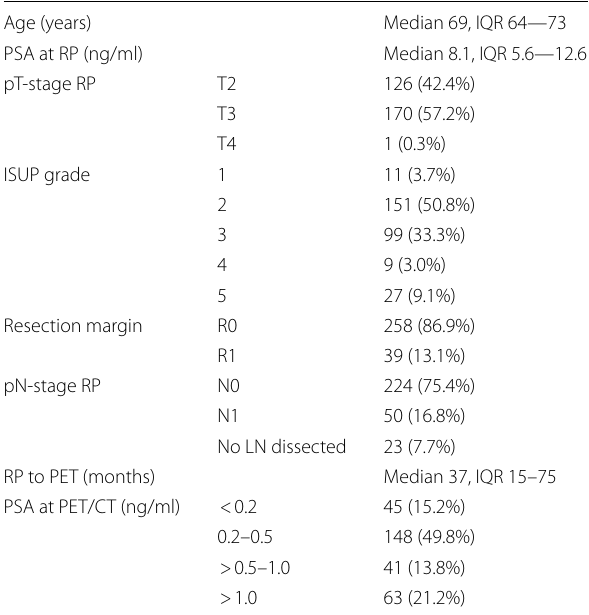
Table 1 Clinical patient characteristics Table 2 PET/CT case positivity rate by PSA level and